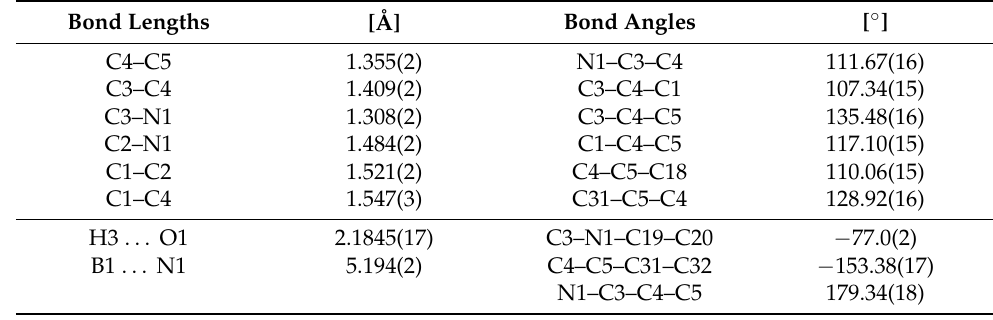
Figure 2. ORTEP of 3 · H 2 O with thermal ellipsoids at 50% probability. Table 1. Selected bond lengths [Å] and bond angles [°].